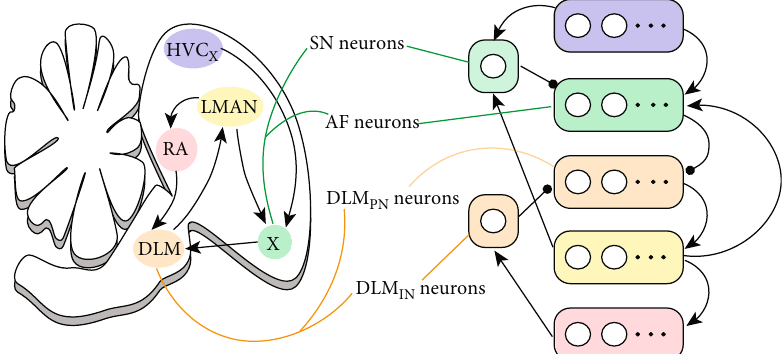
Figure 3: Neural structure of the anterior forebrain pathway (AFP) consisted of Area X, DLM, and LMAN. There are spiny neurons (SN) and fast-spiking neurons (AF) in Area X, stimulated by HVC neurons. AF neurons also get inputs from SN neurons and LMAN while X simultaneously inhibiting DLM projection neurons (DLM ). DLM neurons are under local inhibition caused by the DLM inhibitory PN PN ). They stimulate LMAN, which fi nally sends delayed input to RA. Inhibitory neurons, SN and DLM neuron (DLM IN LMAN and RA, respectively. Arrow lines represent excitatory projections, while circle-headed lines represent inhibitory